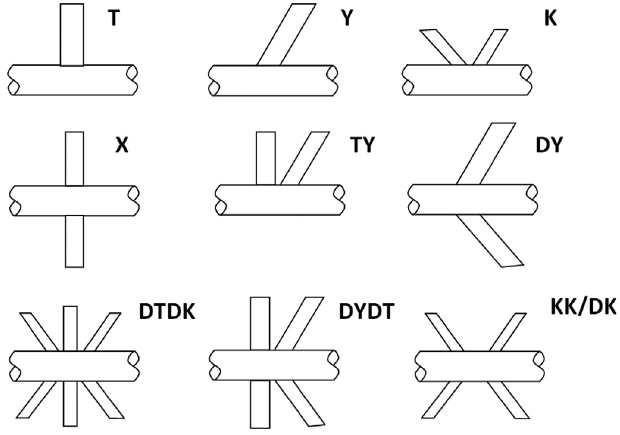
Figure 5. Types of tubular joints along with their nomenclature [10].